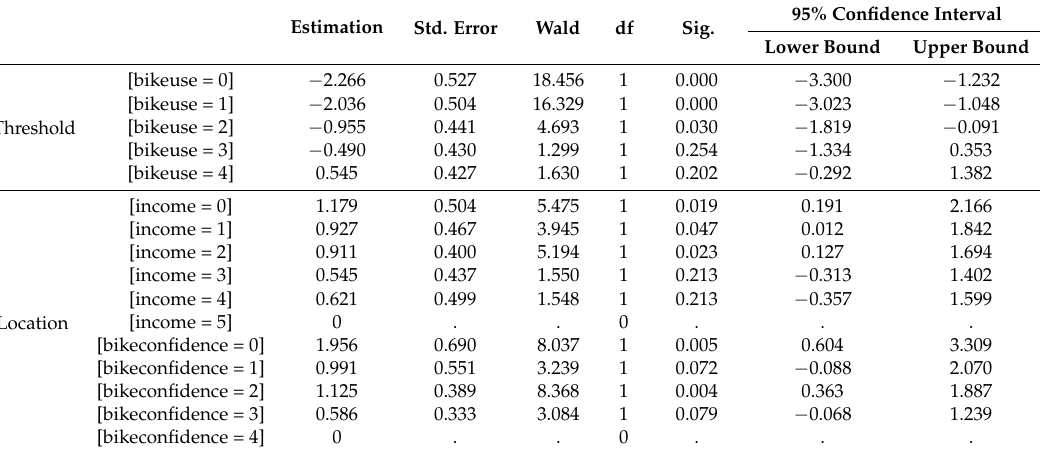
Table A3. Parameter Estimates for the bicycle model.